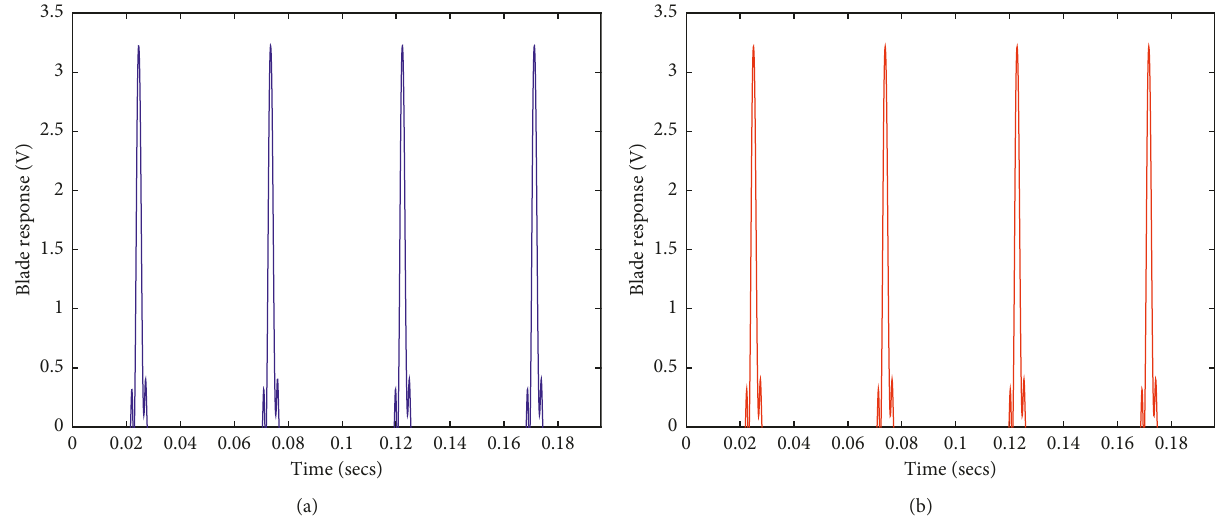
Figure 12: AECS reconstructed BTT signals of blade 8 for a speed of 100rpm. (a) Undamaged and (b) damaged